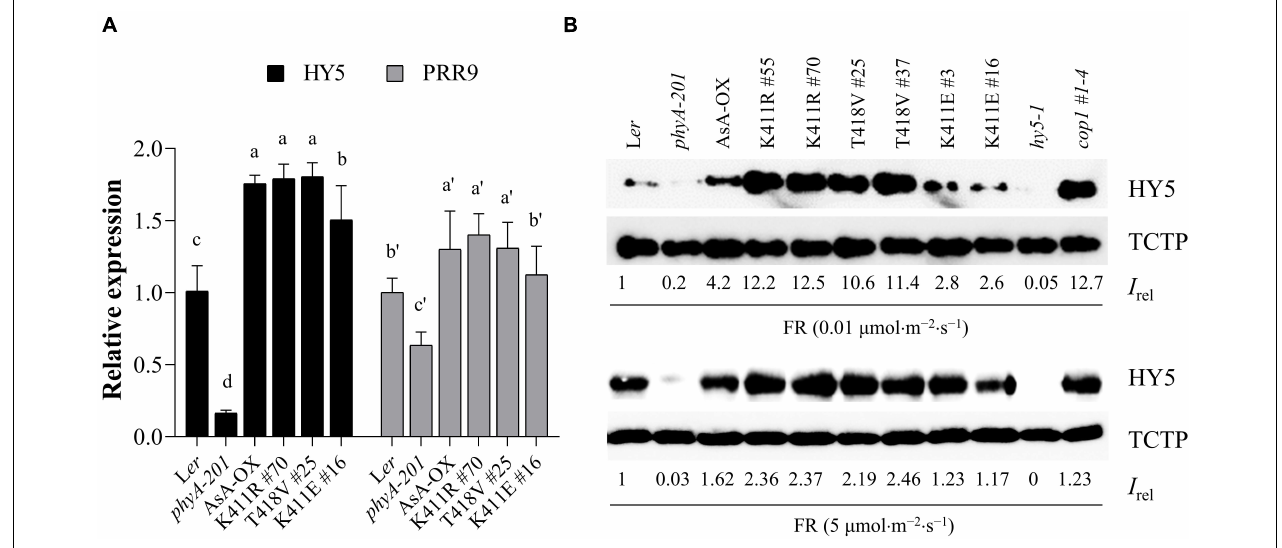
FIGURE 5 | HY5 accumulation in transgenic plants with AsphyA kinase mutants under FR light. (A) Quantitative RT-PCR analysis of HY5 and PRR9. Three-day-old dark-grown seedlings were exposed to FR (10 µ mol · m − 2 · s − 1 ) for 1 h, before RNA extraction. The transcript level of ACT2 was used for normalization, and the relative expression levels were estimated assuming the transcript levels in L er as 1. Data represent means ± SD from three independent measurements. Means with different letters are significantly different at P < 0.01, using Duncan’s multiple range test. (B) Measurements of HY5 accumulation in response to FR light. Seedlings were grown for 4 days under continuous FR (0.01 or 5 µ mol . m − 2 . s − 1 ) light, and HY5 protein levels were analyzed by western blotting using HY5-specific polyclonal antibody (R1245-1b). The hy5 and cop1 mutants were included as negative and positive controls, respectively. Relative intensities ( I rel ) of HY5 were estimated from the blots using ImageJ, assuming the HY5 band intensity in L er as 1. The band intensity of TCTP was used for